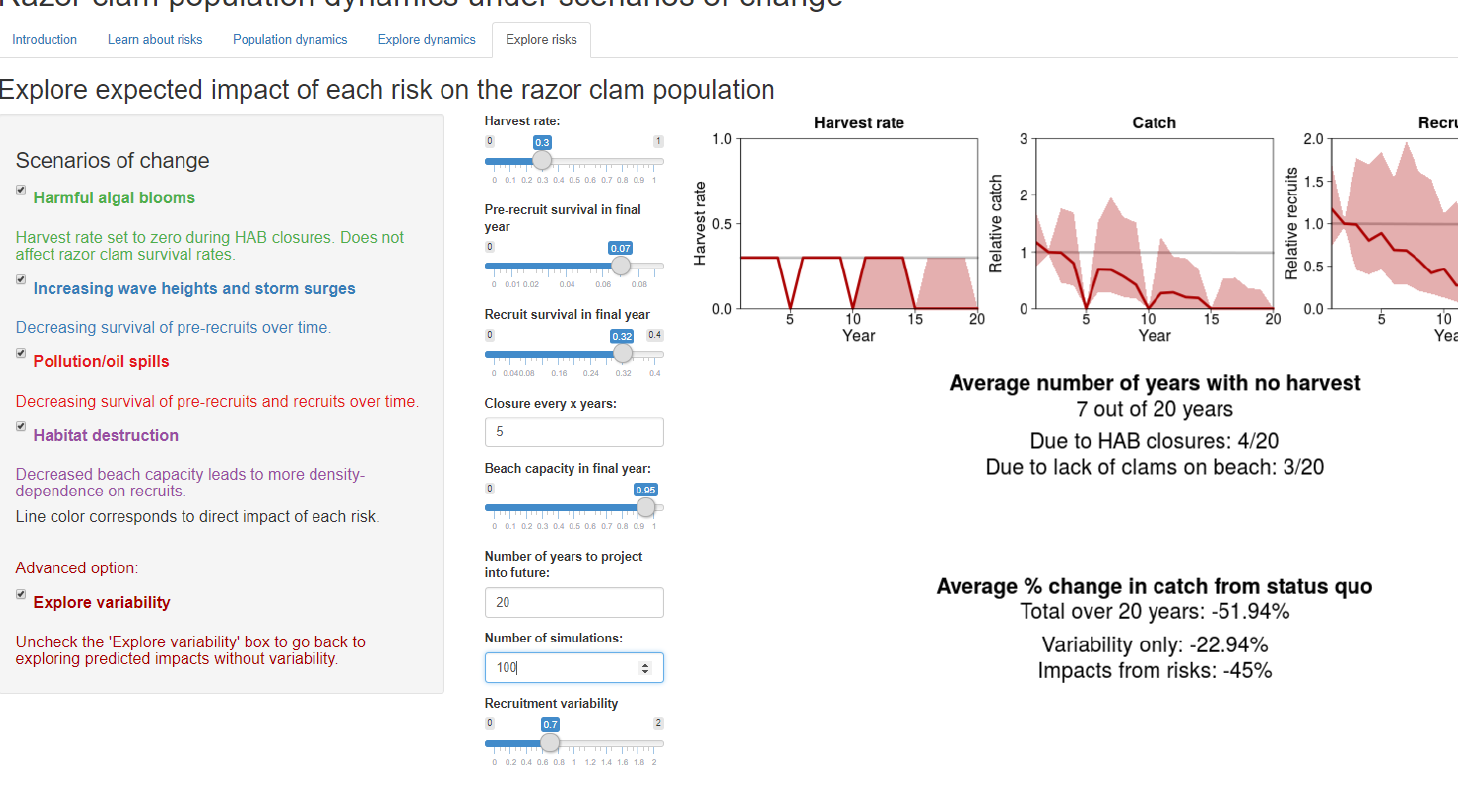
Figure A6.2. Screenshot of the shiny app (https://merrillrudd.shinyapps.io/razor_clam_pop/) “Explore risks” tab where the user can explore variability on top of the expected impact of any combination of harmful algal blooms, increasing wave heights and storm surge, pollution and oil spills, and habitat destruction by including stochastic iterations of simulated populations with lognormally distributed variability on annual recruitment. The user can explore the average number of years with no harvest and average percent change in catch from equilibrium without variability across 100 simulations of projected